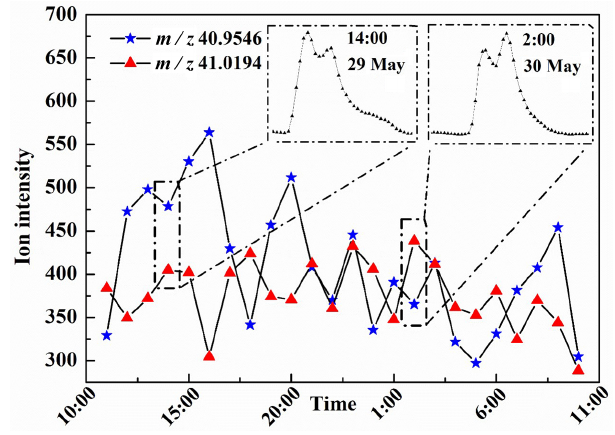
Figure 6. Time series of peak intensities at m/z 40.95 and m/z 41.01. Time is local